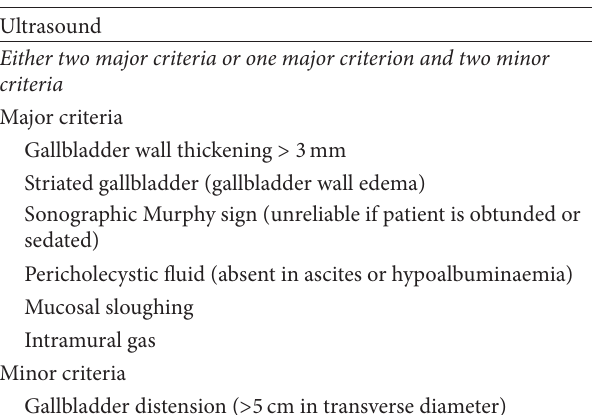
Table 3: Imaging criteria for diagnosis of acute acalculous cholecys-